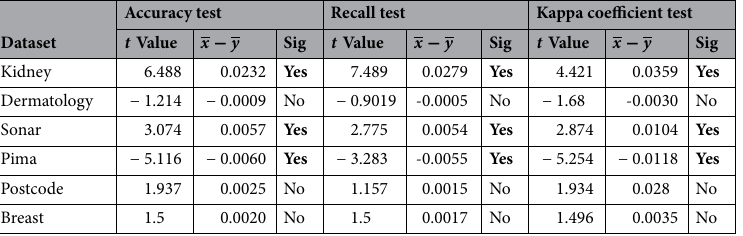
Table 8. The statistical comparison test of the weighted t kernel SVM classification performance at the 2 level p -norm. Sig: significance. Significant values are in bold.